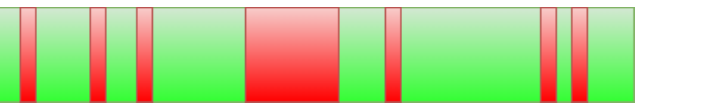
Figure 2. An example of the availability status of cloud services under the ON–OFF